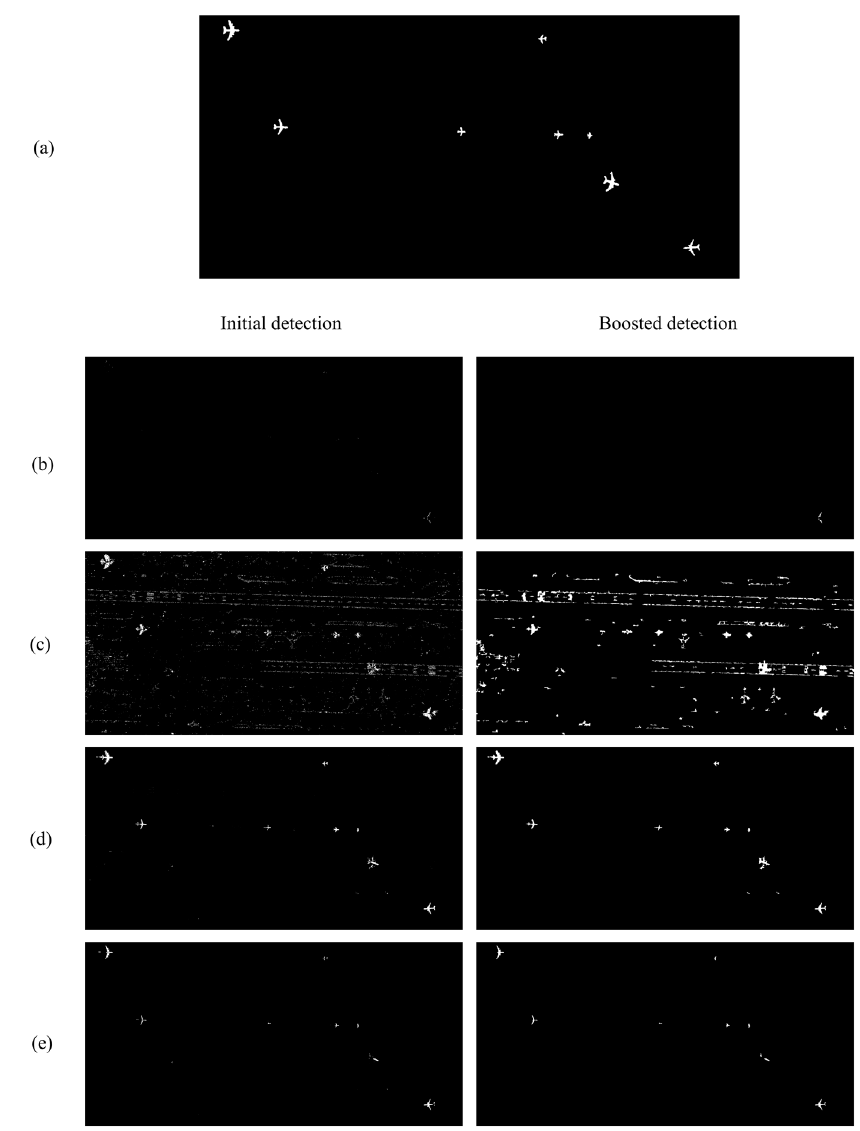
Figure 6. Initial and boosted results of moving airplane detection by four algorithms: ( a ) ground reference; ( b ) Codebook; ( c ) MoG; ( d ) ViBe; and ( e ) our IPGBBS